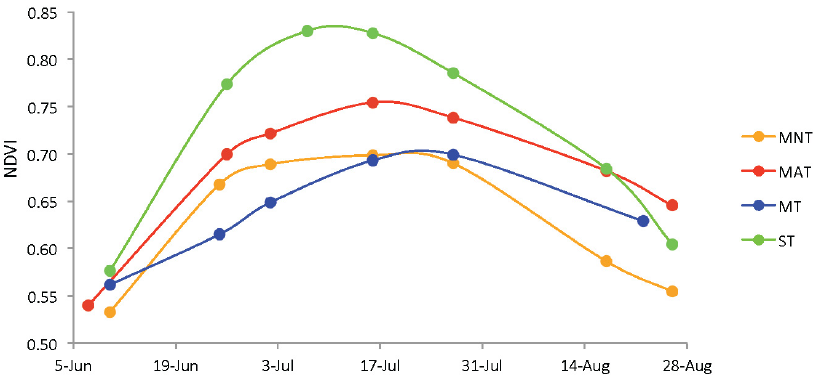
Figure 1. NDVI throughout the 1999 growing season for four different vegetation communities at Ivotuk, Alaska. Adapted from [17]. Measurements were taken using an Analytical Spectral Devices FieldSpec spectro-radiometer.